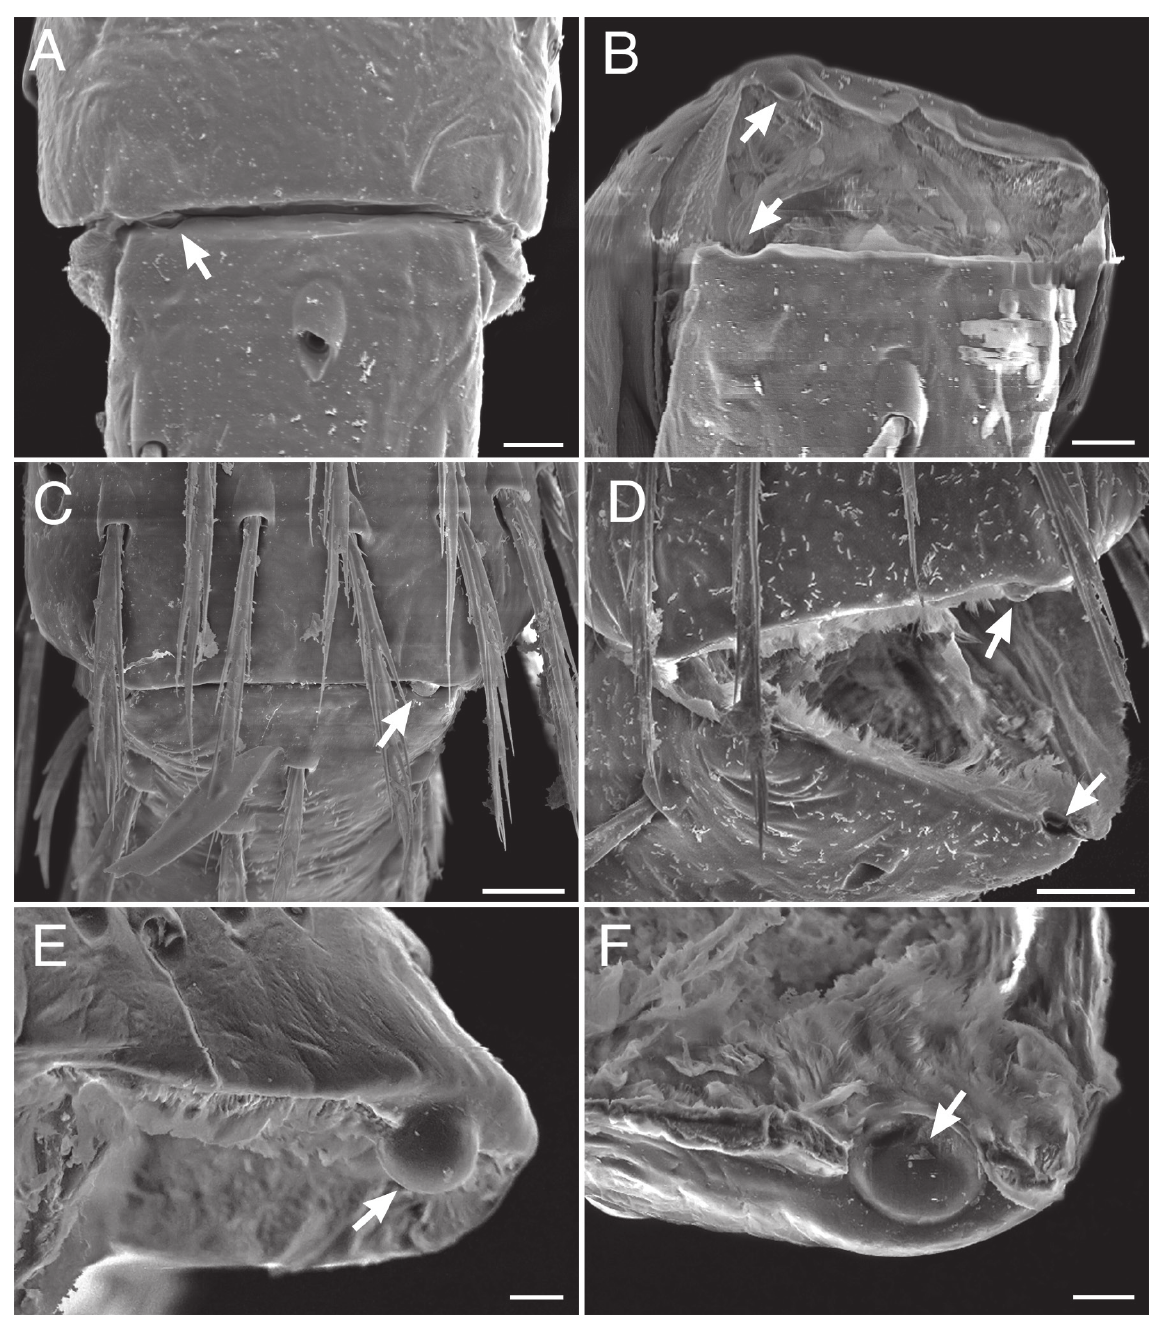
Fig. 20. A . Trygetus sexoculatus (O. Pickard-Cambridge, 1872), ♂, left tibia-metatarsus joint III. B . As previous, left tibia-metatarsus joint II; arrows indicate tibial process and metatarsal concavity. C . Parazodarion raddei (Simon, 1889), ♂, right tibia-metatarsus joint III; arrow indicates tibial process. D . As previous, right tibia-metatarsus joint II; arrows indicate tibial process and metatarsal concavity. E . Diores poweri Tucker, 1920, ♀, right tibia-metatarsus joint IV; arrow indicates tibial process. F . Idem, detail; arrow indicates metatarsal concavity. Scale bars: A–B, e–F = 10 mm, c–d = 20